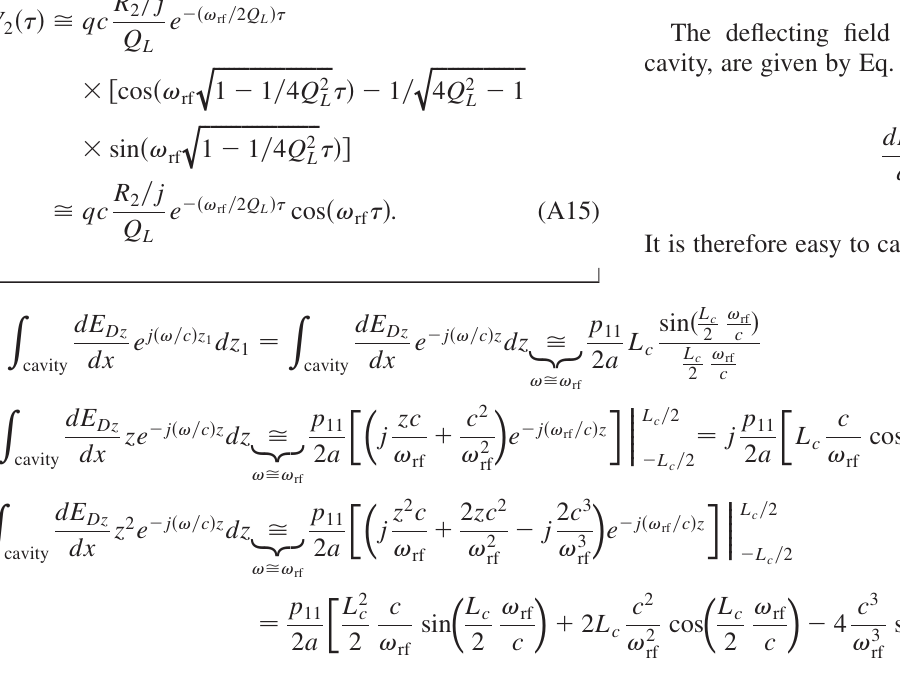
ffiffiffiffiffiffiffiffiffiffiffiffiffiffiffiffiffi